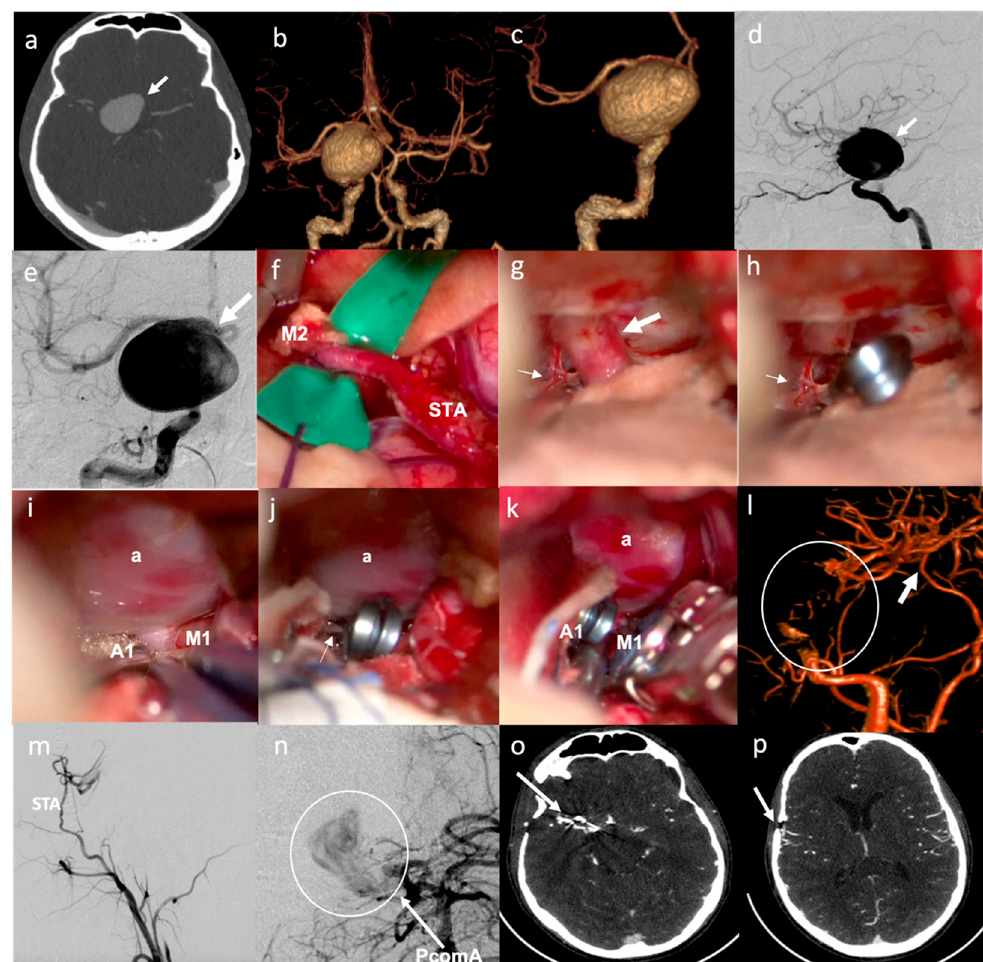
Figure 3. Illustrative case of “Complex” aneurysms with only surgical treatment (bypass and partial trapping because of subsequent aneurysm thrombotic occlusion): ( a ) CT-angio showing giant R ICA aneurysm (arrow); ( b , c ) 3D reconstruction of aneurysm (arrow); ( d , e ) Preoperative DSA showing R ICA aneurysm (arrow) in sagittal and coronal view; ( f ) Intraoperative view of STA–MCA bypass; ( g , h ) Intraoperative pre- and post-surgical clipping view of supraclinoid ICA (large arrow) and ophthalmic artery (thin arrow); ( i – k ) Intraoperative view of distal clipping (aneurysm = a); ( l ) Postoperative 3D reconstruction showing aneurysm trapping (circle) and bypass patency (arrow); ( m , n ) Postoperative DSA showing STA–MCA bypass patency in lateral view and aneurysm partial trapping with slow perfusion flow from PcommA; ( o , p ) Follow-up CT-angio showing bypass patency and aneurysm occlusion.